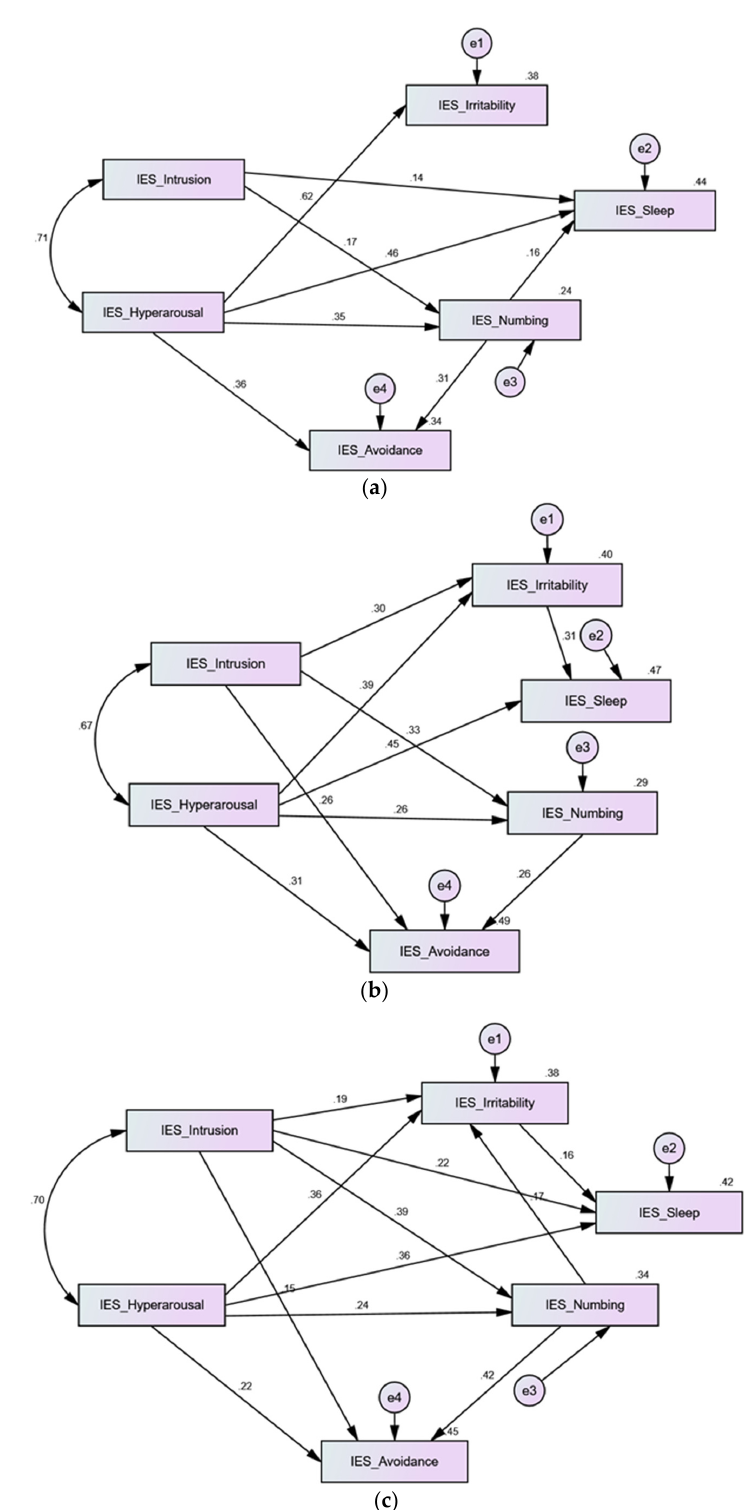
Figure 2. Path analysis model predicting the relationships among factors comprising the Arabic version of the Impact of Event Scale-Revised (IES-R) in the quarantine sample ( a ), psychiatric patients ( b ), and healthy individuals ( c ). The intrusion and hyperarousal subscales of the IES-R were used as predictors and other subscales were dependent variables. Direct effects of the predictors are noted by values on the arrows while indirect relationships are reported in the text. Most variables predicted avoidance both directly and indirectly.